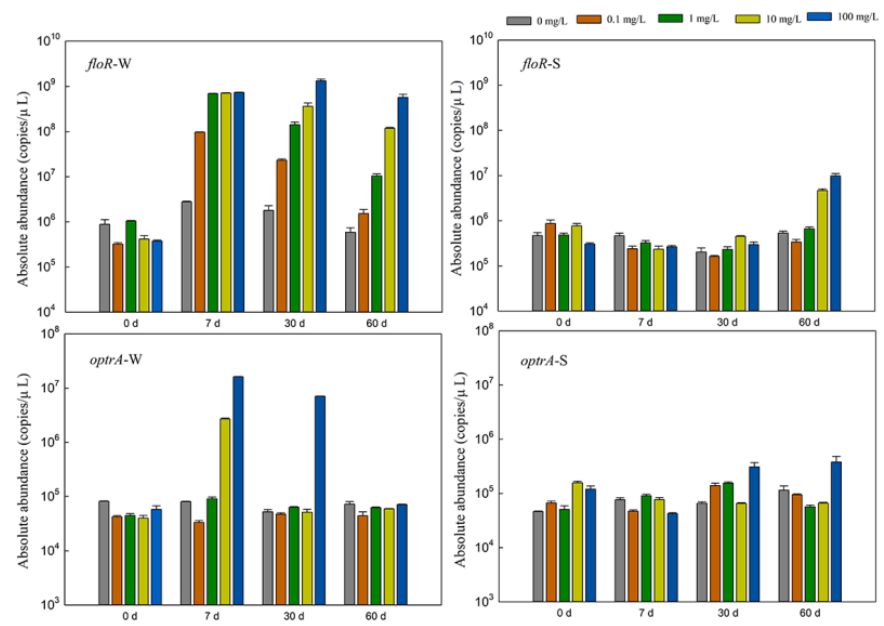
Figure 1. Effects of different concentrations of florfenicol on the abundance of antibiotic resistance genes (ARGs) in an aquatic microcosm model. W, water; S, sediments.